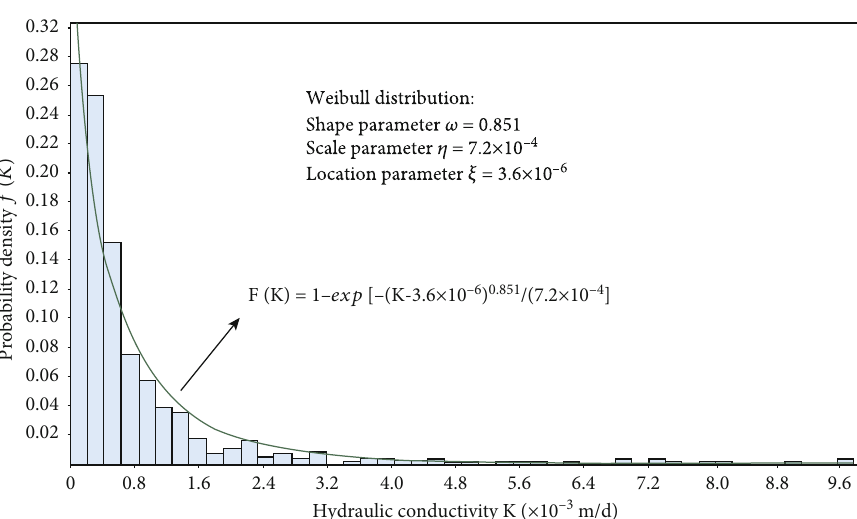
Figure 4: Distribution characteristics of hydraulic conductivity in fresh or slightly weathered